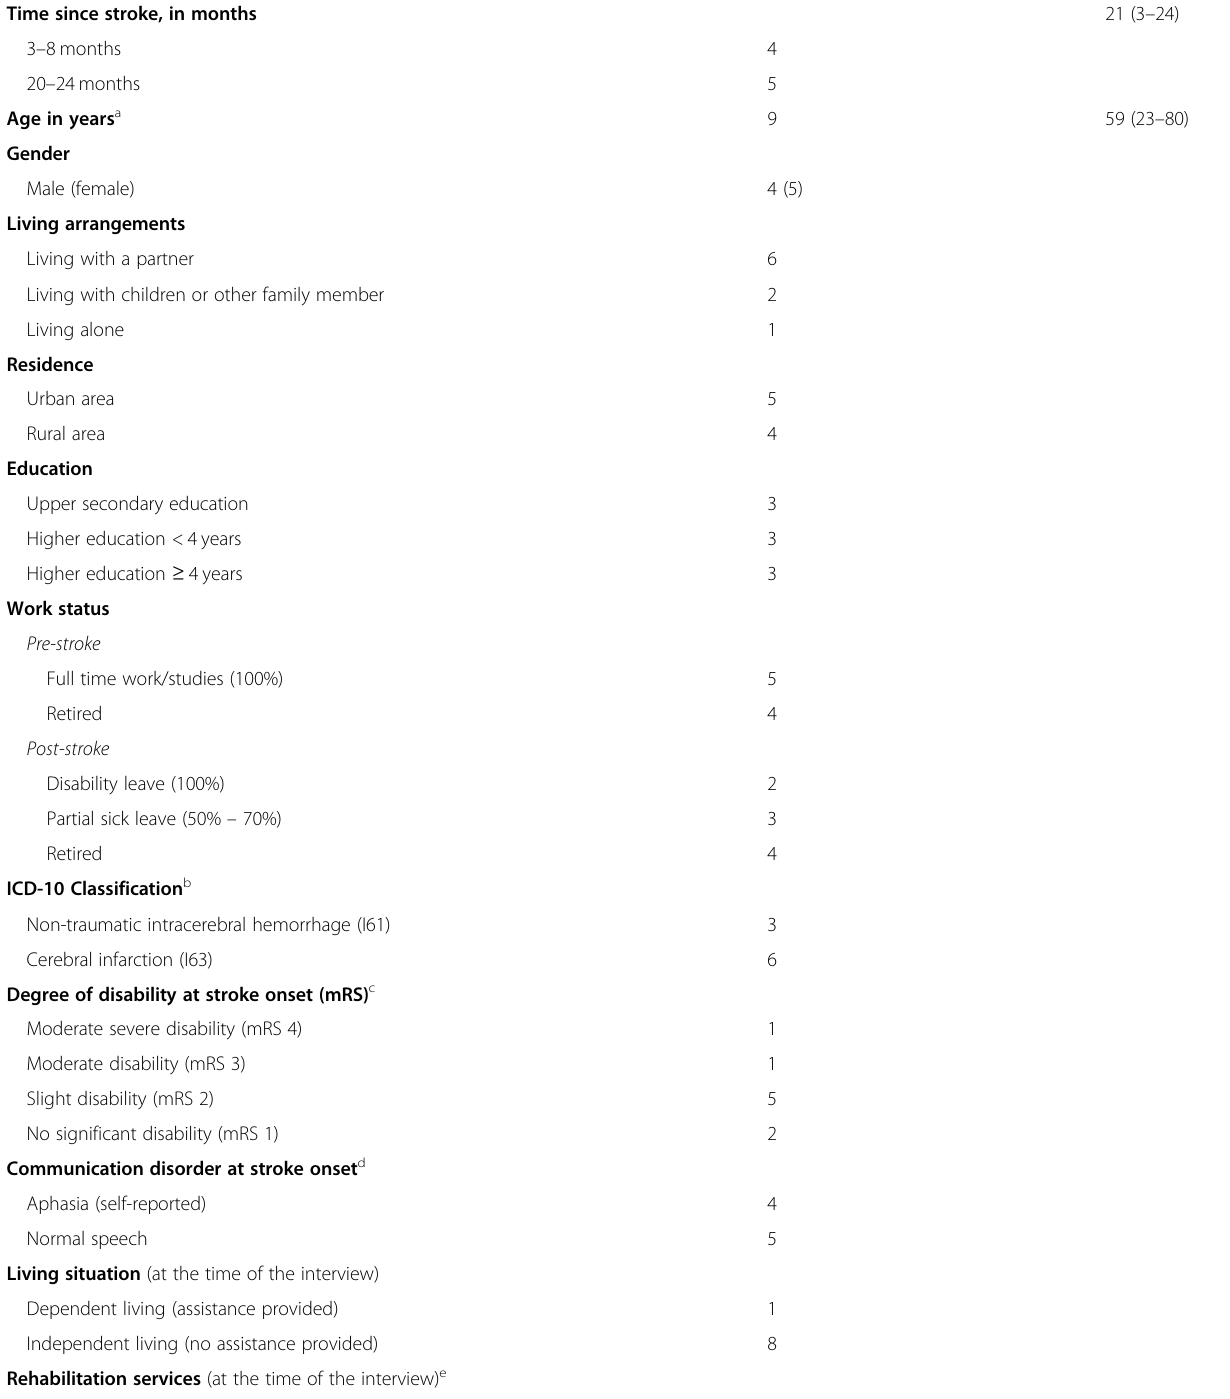
Table 2 Demographics, clinical characteristics and health-related quality of life of the stroke survivors with PSF (individual interview